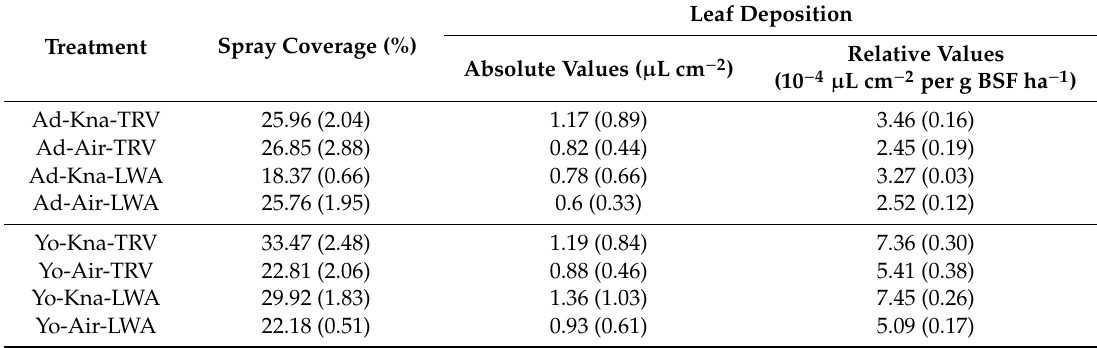
Table A1. Spray coverage (%) (mean (s.e.)), absolute leaf deposition ( µ L cm − 2 ) (mean (s.e.)), and normalized leaf deposition ( µ L cm − 2 per g of BSF ha − 1 ) (mean (s.e.)) for each treatment combination of plot–sprayer–dose expression.